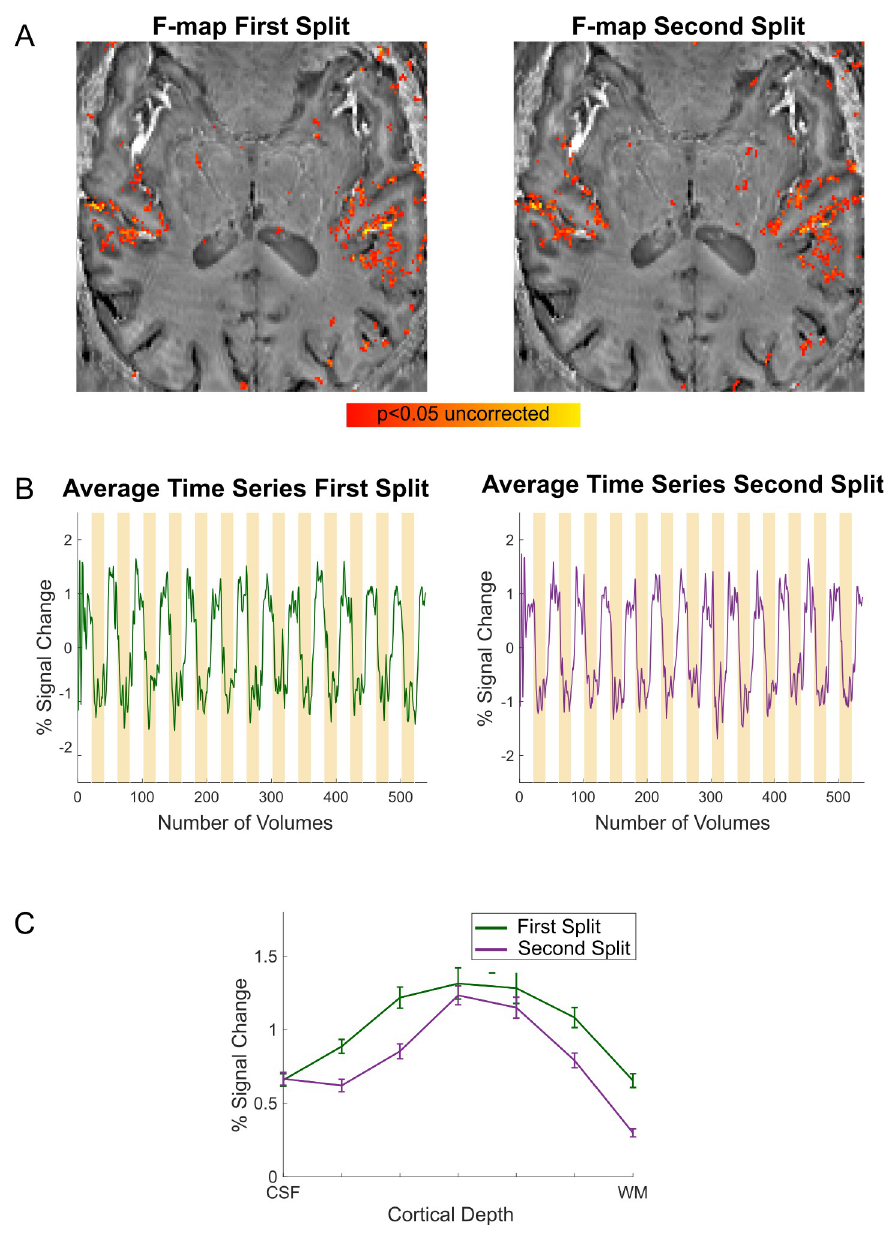
Fig 5. Stability of responses. (A) F-maps (p < 0.05 uncorrected) are displayed on a bias field corrected mean EPI VASO image. (B) Time courses in percent signal change are displayed against our experimental paradigm, illustrating the negative signal change upon auditory stimulation (yellow bars). (C) Laminar responses in a functional activation based ROI for both splits of the